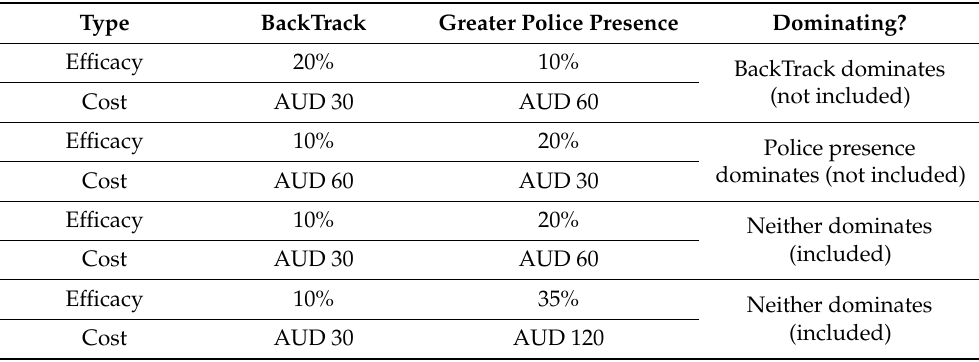
Table 2. Example choice sets that were included and excluded from the design due to dominating